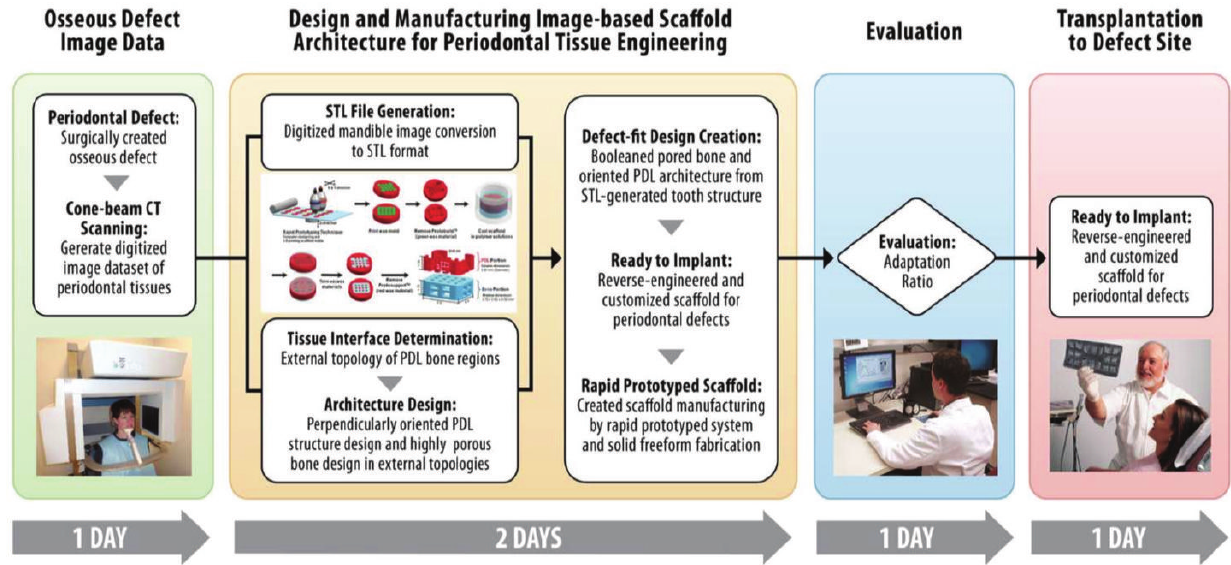
Figure 3: CAD models are produced based on computed tomography (CT) scans of a patient-specific bone defect to develop a custom-made bone graft substitute. Courtesy of Park et al., 2014